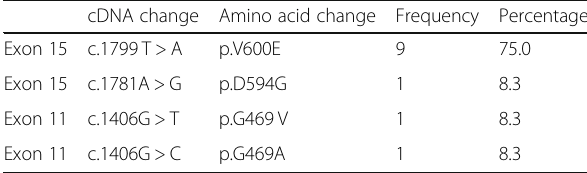
Table 11 BRAF mutations in 12 lung